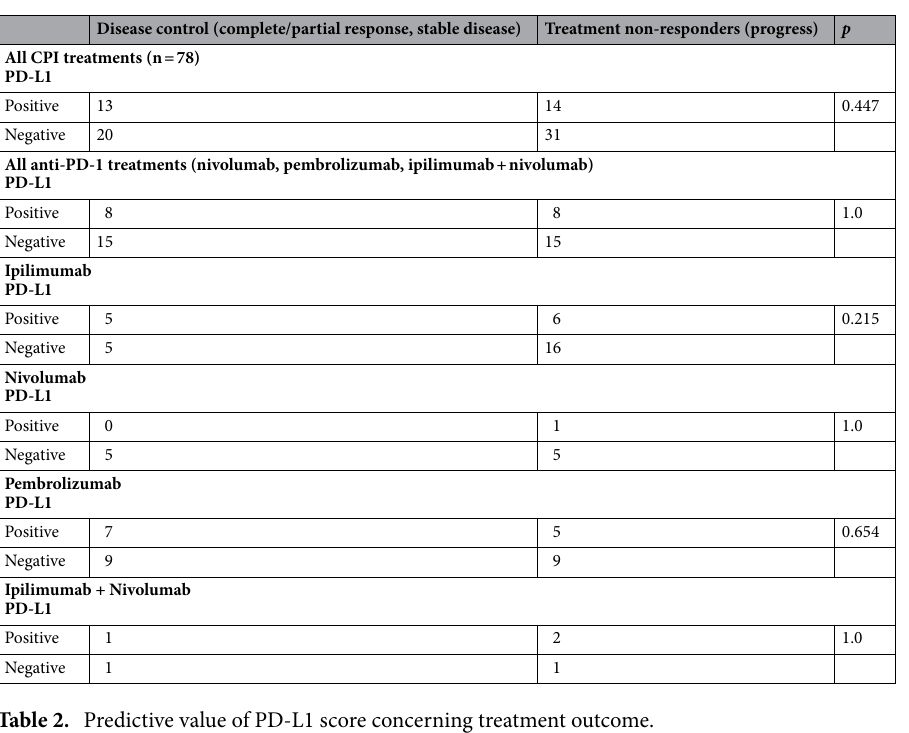
Table 2. Predictive value of PD-L1 score concerning treatment outcome.